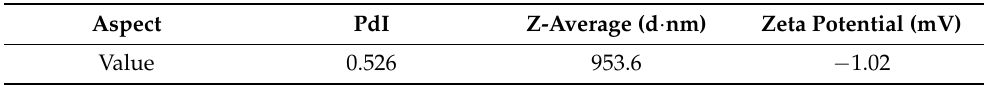
Table 1. Zeta potential and particles size analysis.